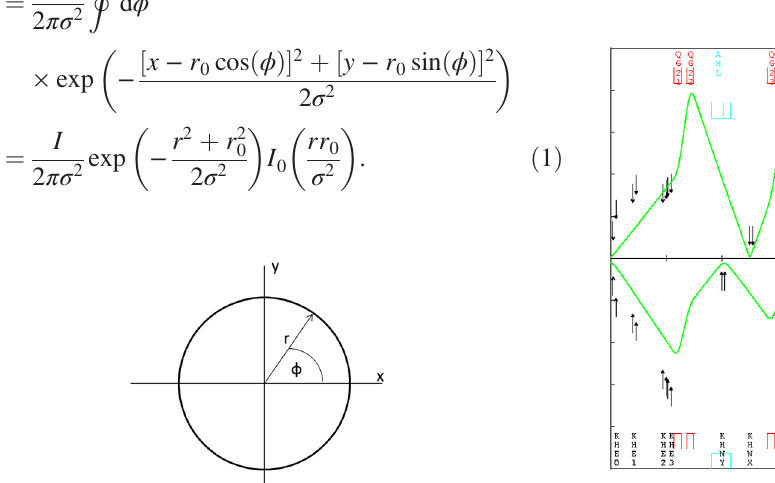
FIG. 3. Coordinate system. The protons are traveling along the z axis. r 2 ¼ x 2 þ y 2 .